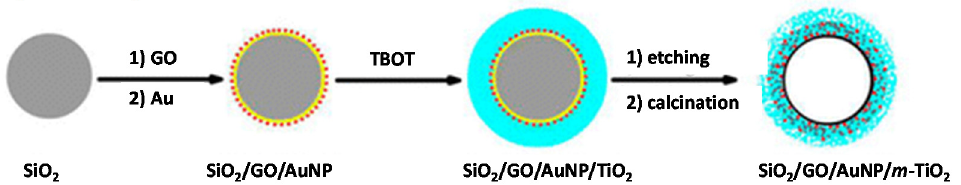
Figure 10. Schematic illustration of the synthesis steps for r-GO/AuNP/m-TiO 2 sandwich-like hollow spheres. Reprinted with permission from [45]. Copyright (2015) ACS.